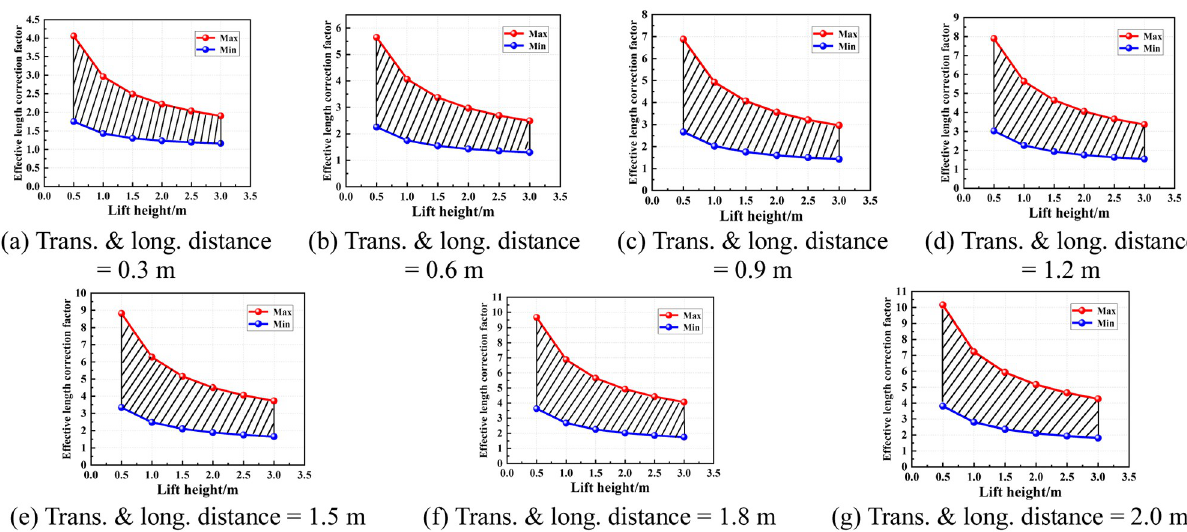
Fig 18. Value areas of the effective length correction factor of condition 3. (a) Trans. & long. distance = 0.3 m. (b) Trans. & long. distance = 0.6 m. (c) Trans. & long. distance = 0.9 m. (d) Trans. & long. distance = 1.2 m. (e) Trans. & long. distance = 1.5 m. (f) Trans. & long. distance = 1.8 m. (g) Trans. & long. distance = 2.0